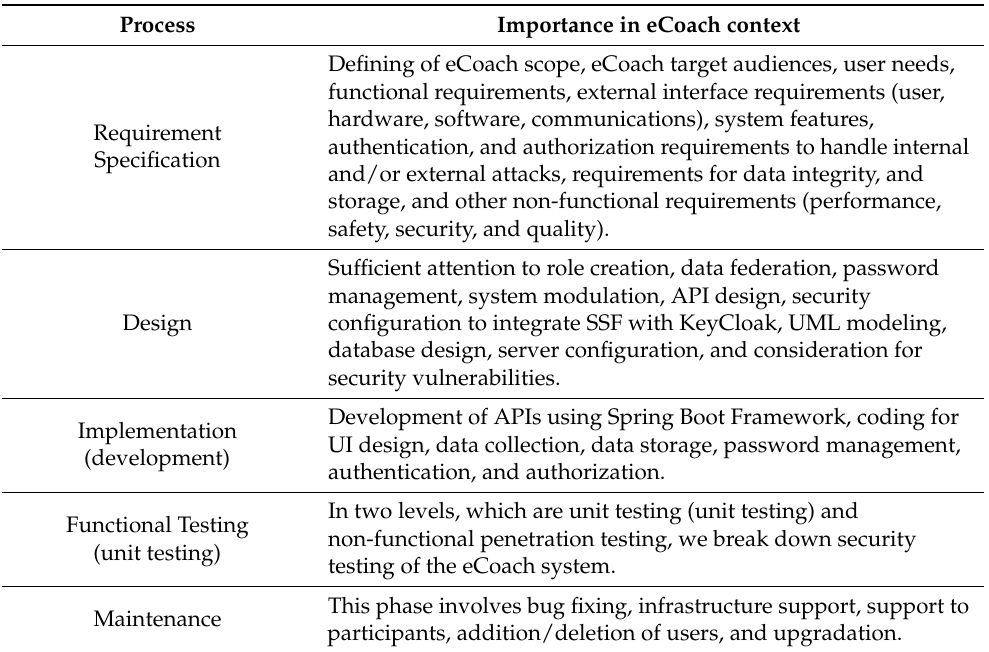
Table 3. Importance of the SDLC processes in eCoach